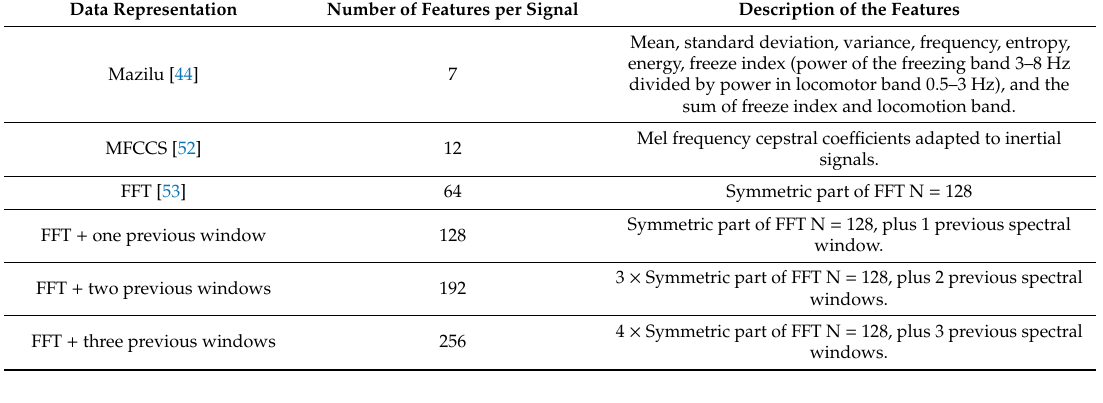
Table 2. Summary of the data representations used in the current study.